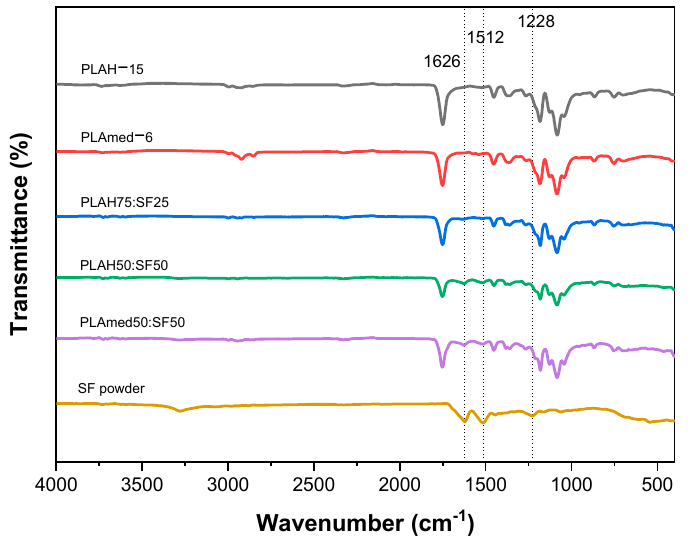
Figure 5. FTIR spectra of SF powder, PLAH − 15, PLAH75:SF25, PLAH50:SF50, PLAmed − 6, and PLAmed50:SF50